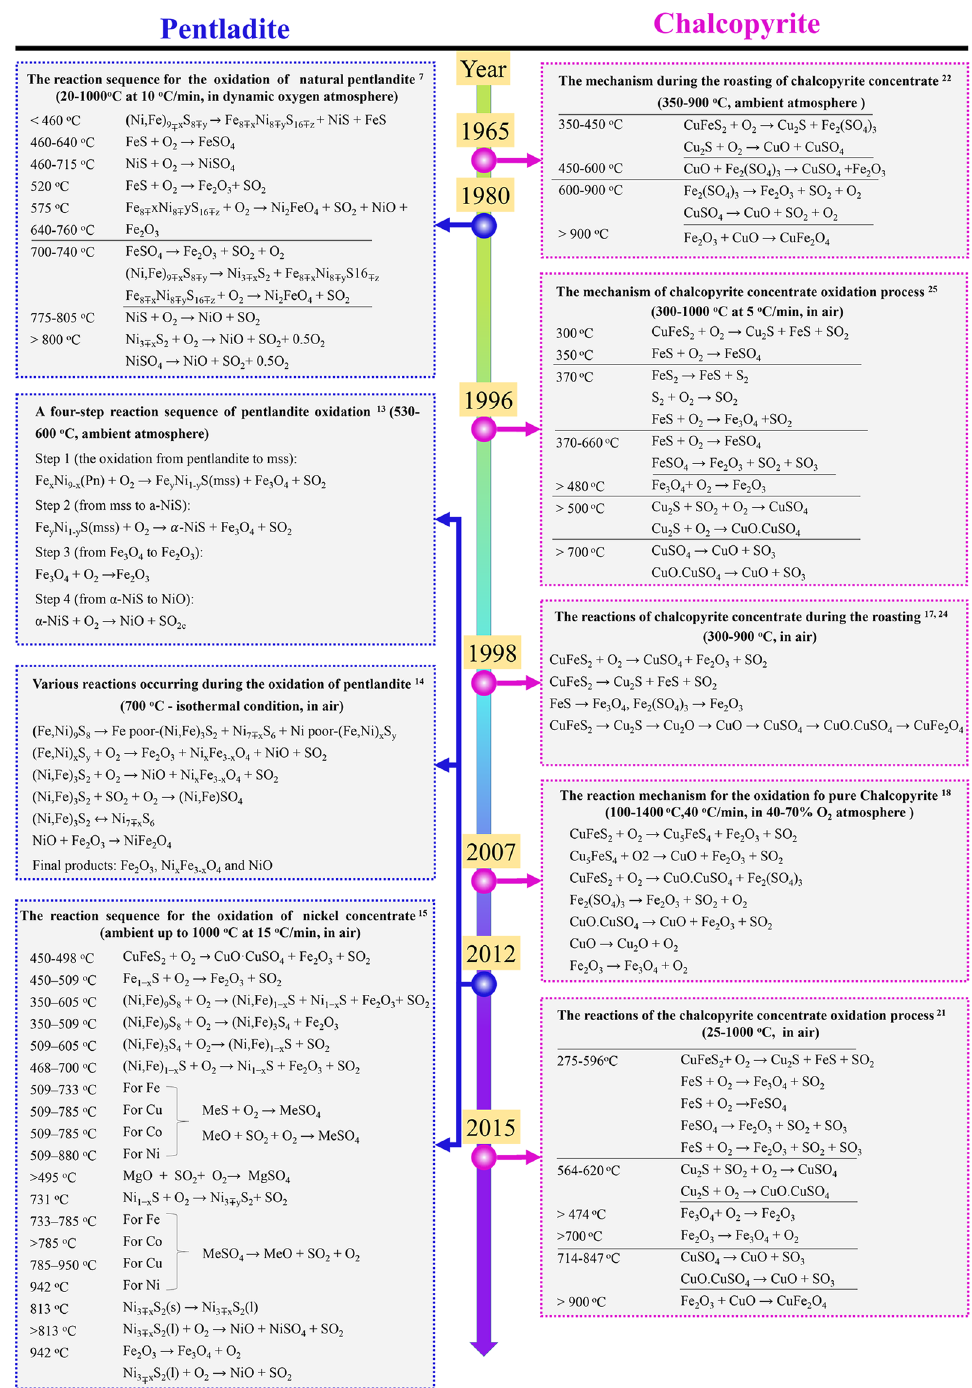
Figure 1. Summary of the oxidative reaction sequence for Pn and Ccp from early